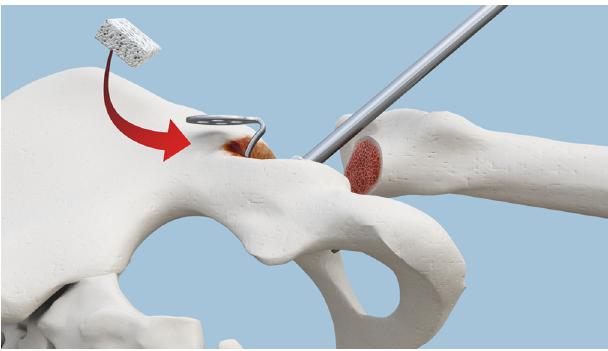
Figure 4. The gap is fi lled with a graft. Lateral view.